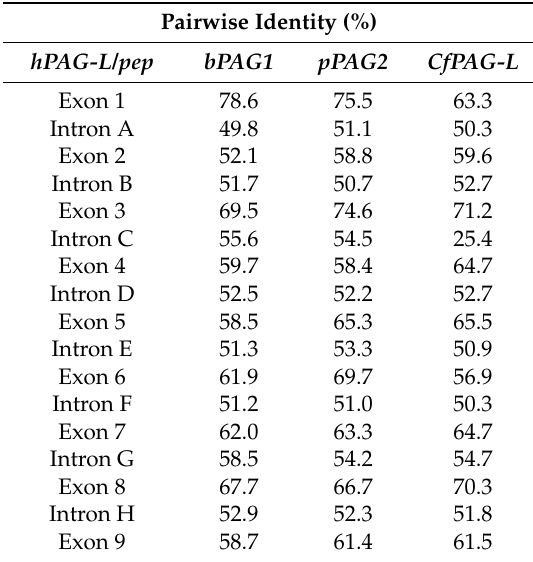
Table 6. Homology of the hPAG-L/pep exons and introns with bPAG1 , pPAG2 and CfPAG-L genes. Pairwise Identity